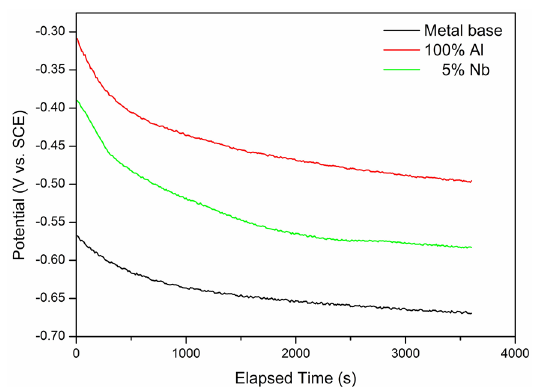
Figure 7. Open potential curves